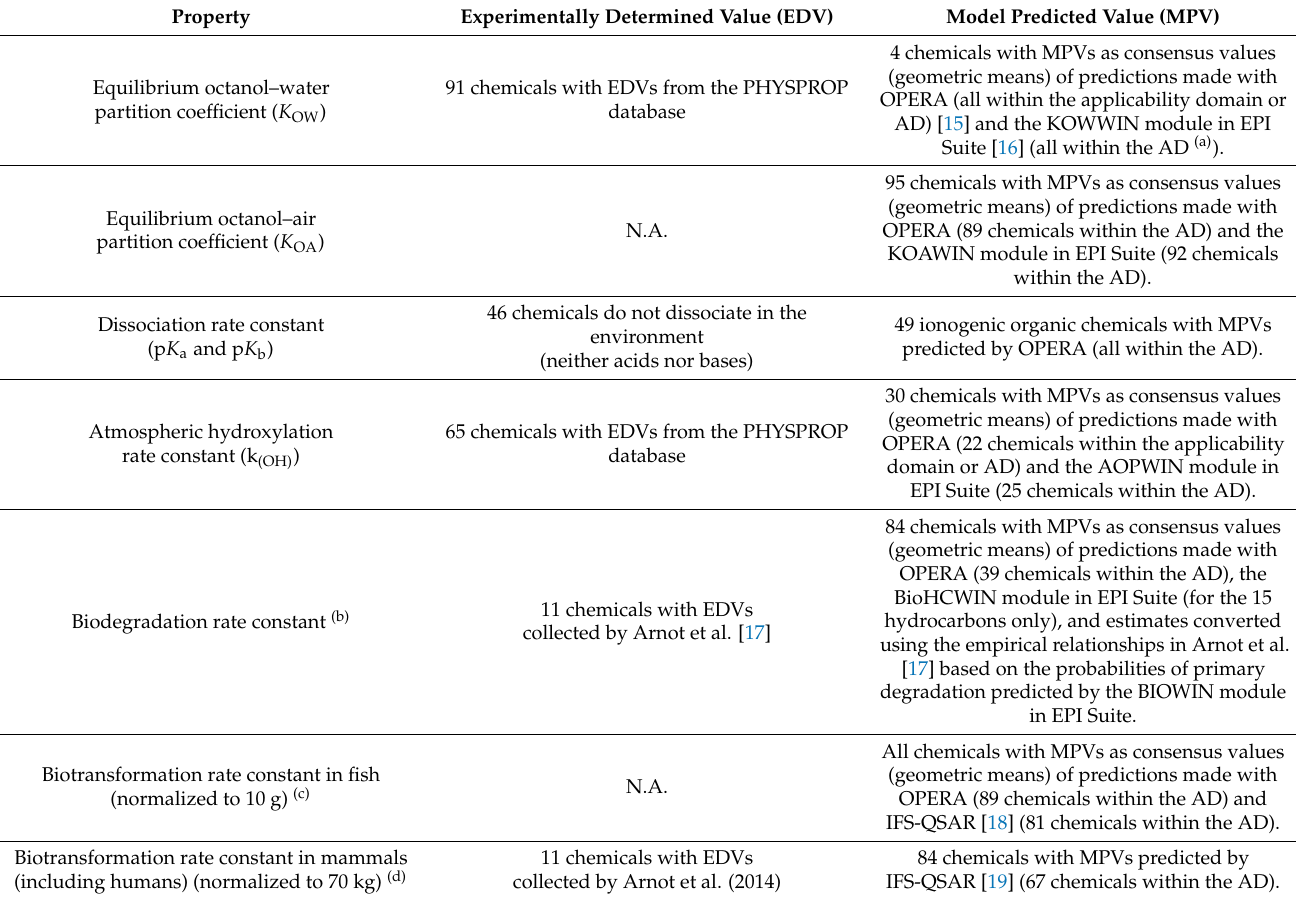
Table 1. Properties of the 95 organic chemicals examined in this